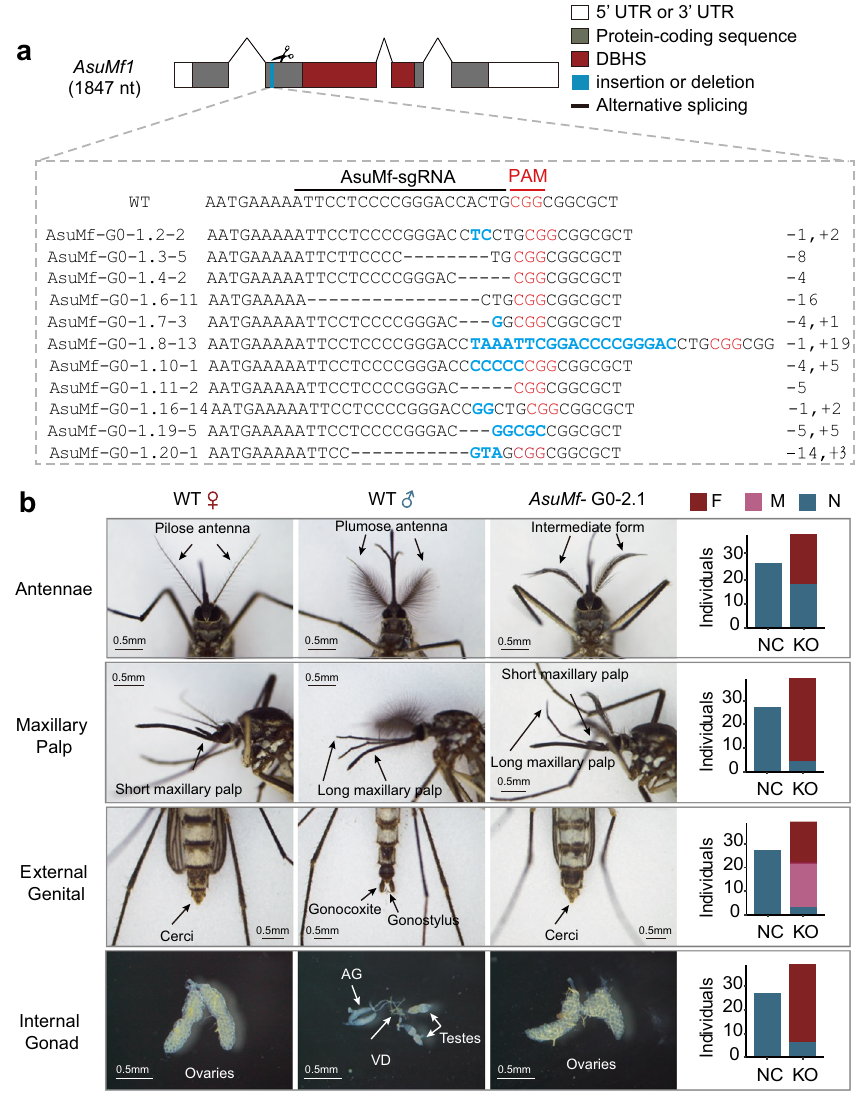
Fig. 2 | AsuMf - mosaic gene ablations result in feminized and morphologically deformed males. a Relative location and representative nucleotide sequences of Cas9/sgRNA-inducedmutationsinthe AsuMf genethataffectthe AsuMf1-3 isoforms (Fullsequences are listed inSupplementary Fig. 5). Ampliconsspanning the sgRNA target site (top) were sequenced and analyzed for indel mutations (bottom). The fi rst line represents the wild-type sequence, and subsequent lines show individual mutant clones. Deleted bases are marked with dashes and inserted or substituted bases are bolded in blue. The PAM sequences are represented in red. b Representative images of Ar. subalbatus wild-type females and males and Ar.